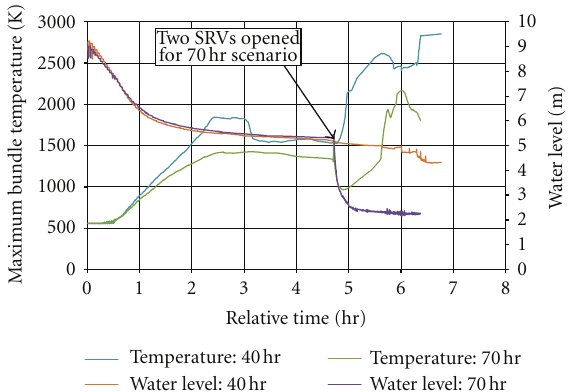
Figure 28: Maximum bundle temperature and water level for the two scenarios with initial loss of the emergency water injection at 40 hours and 70 hours.